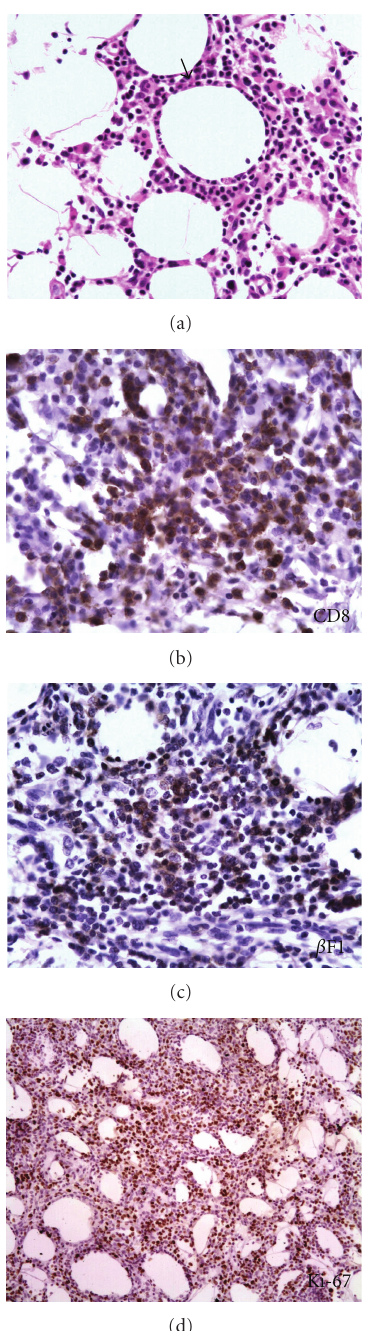
Figure 2: ( a) Di ff use infiltration of small- and medium-sized pleomorphic lymphocytes is seen between the fat cells with rim- ming of the neoplastic cells around one individual fat cell (arrow) (H&E stain; original magnification × 320). (b) CD8 positivity of the neoplastic cells (original magnification × 400). (c) The majority of the cells presents the αβ phenotype ( β F1, original magnification × 640). (d) A high proliferative index of the malignant cells is observed (Ki-67, original magnification ×